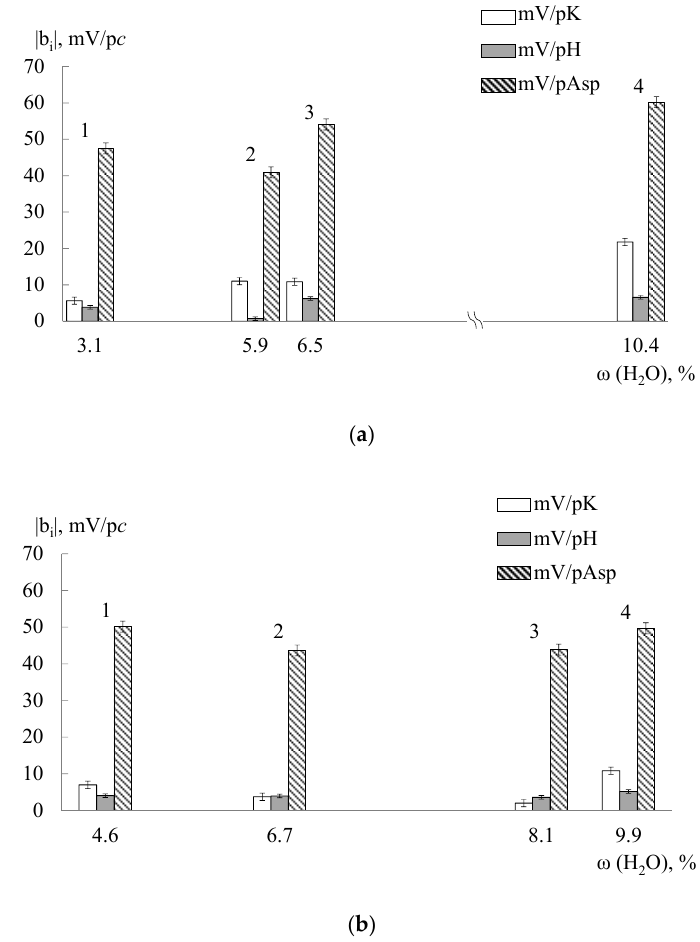
Figure 6. The dependence of DP-sensors’ sensitivity coefficients to ions in the Asp + KOH solutions (pH 3.99–8.20) on the water uptake (in the K + -form) of MF-4SC (extrusion) ( a ) and Nafion (extrusion) ( b ) membranes: 1—RH = 60%, t = 95 °C; 2—mechanical deformation of 80%, t = 80 °C; 3—initial sample; 4—t ht = 120 °C.